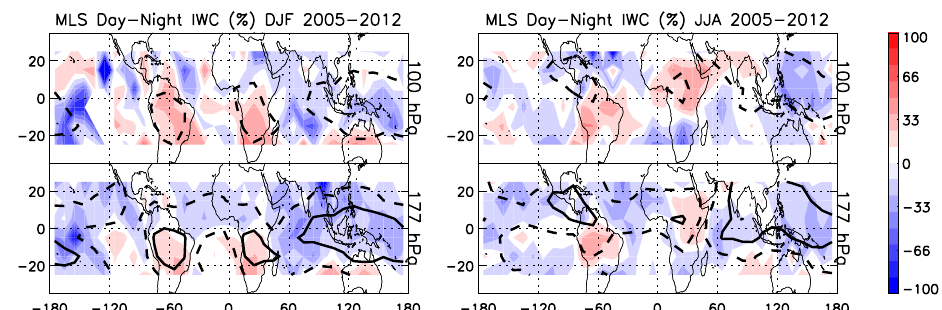
Figure 5. Same as Fig. 2 but for IWC at 177 and 100hPa. The solid black and dashed black lines represent the IWC occurrences over the 2005–2012 period (50 and 15%,